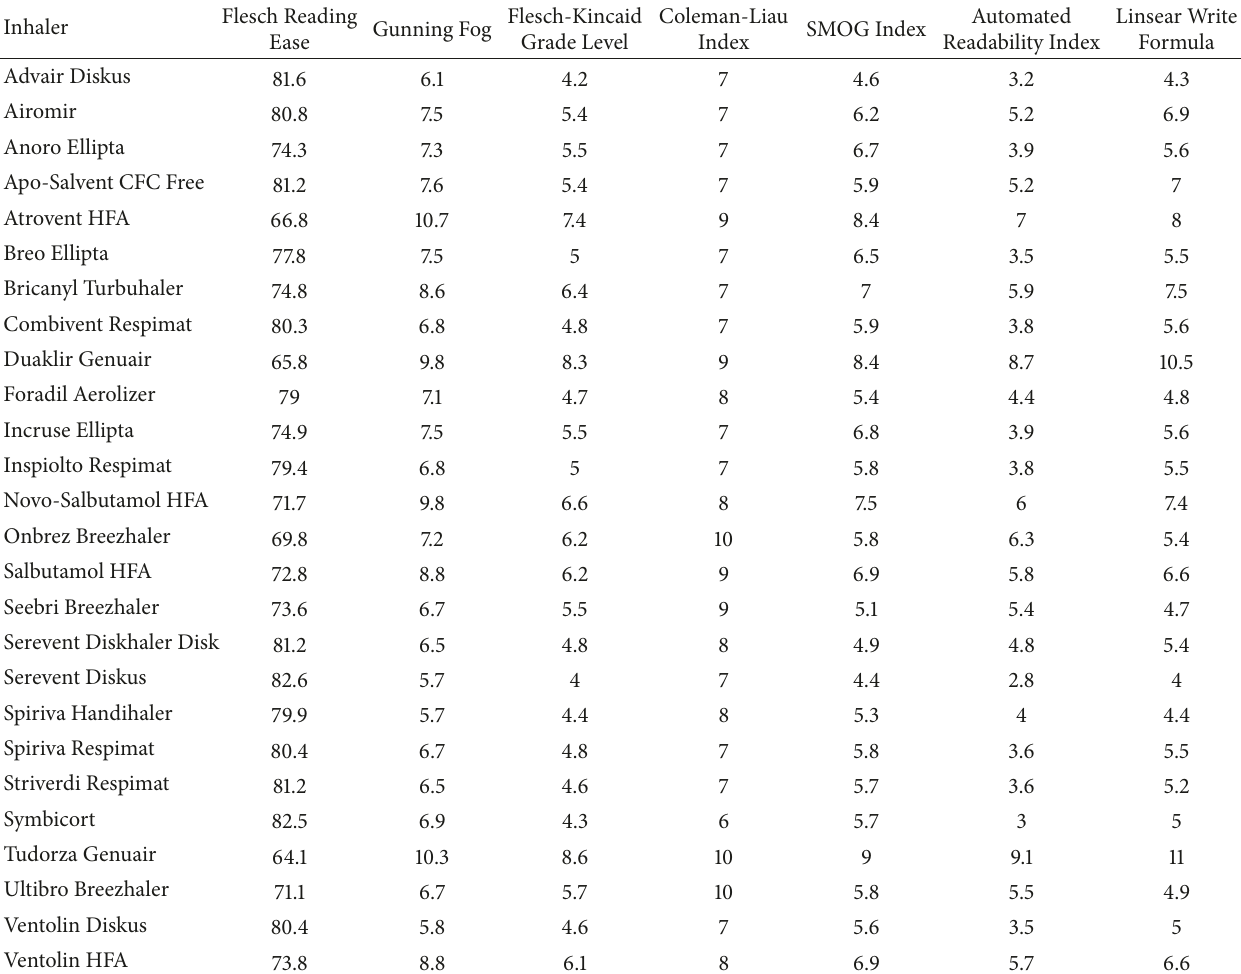
Table 5: Readability of inhaler use